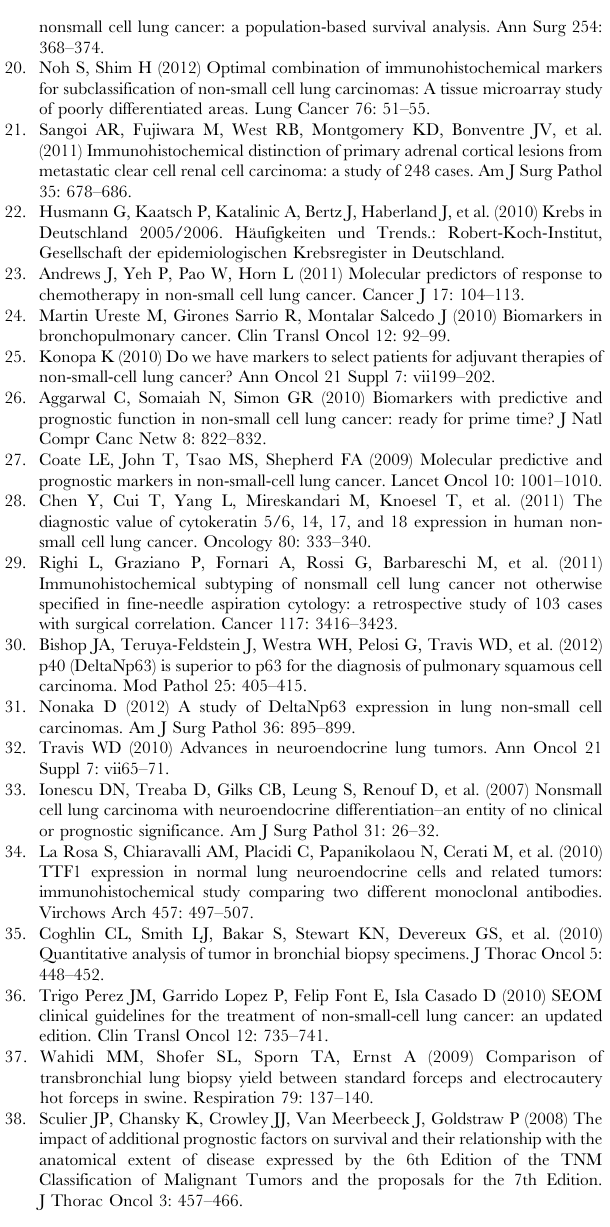
Table S1 Summary of AUC values for each tested marker in relation to the subtypes of NSCLC. TTF1 and p63 prove to be of highly significant value for evaluation of linage